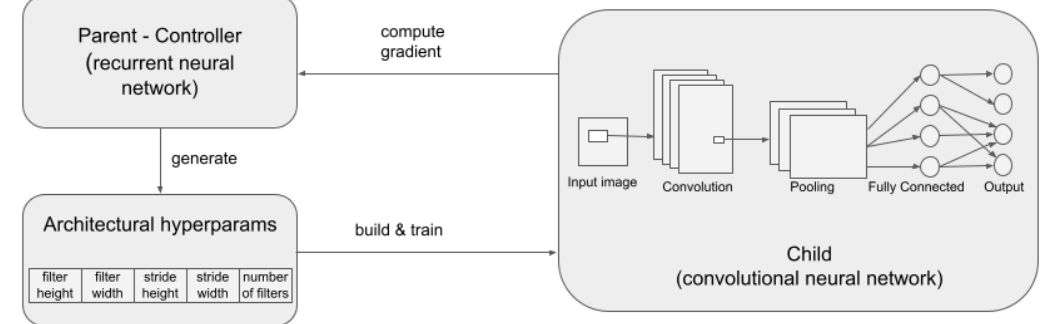
Figure 4. General image analysis employing CNNs with reinforced learning for bee identification and varroosis